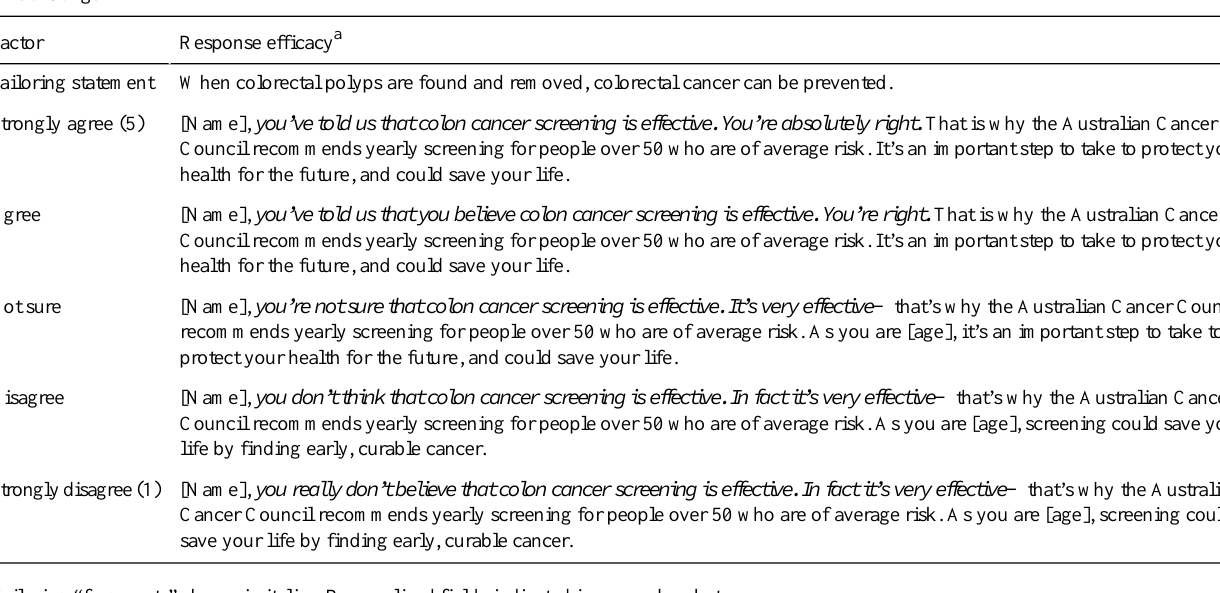
Table 3. Creating a library of tailored messages for the Preventive Health Model (PHM) factor “response efficacy” presented in order from reinforcing to motivating.